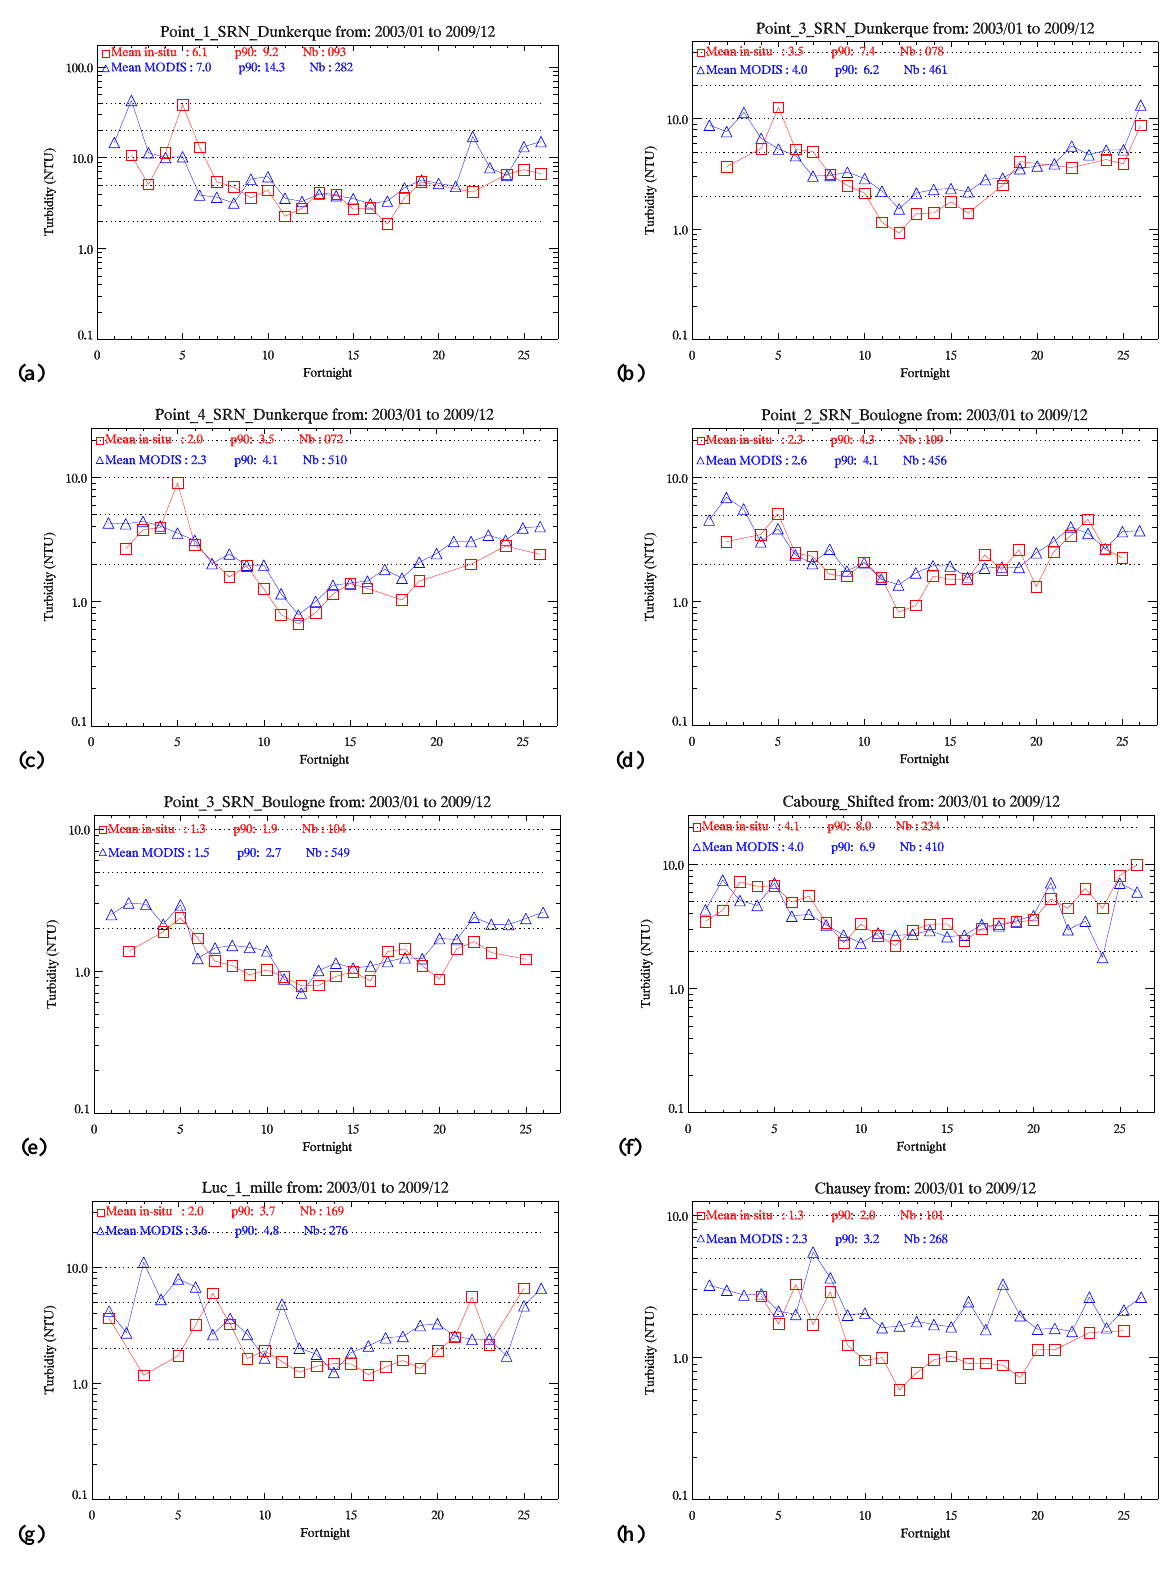
Fig. 11. The annual cycles of turbidity at some selected stations from the North Sea to Northern Brittany. Statistics indicated on the graphs (mean, p90, Nb samples available) concern the productive season (March to